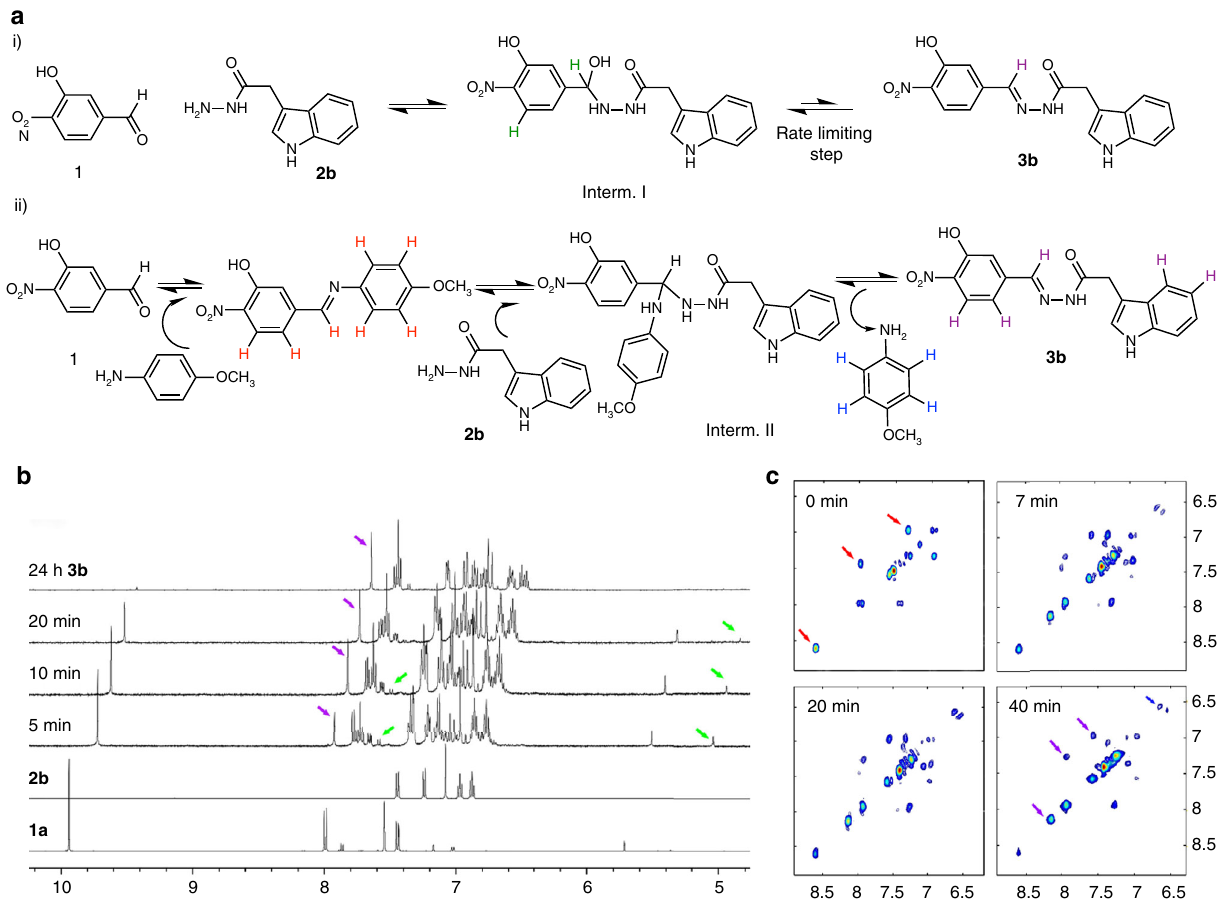
Fig. 3 Acylhydrazone exchange reaction mechanism. a Formation of acylhydrazone 3b in the absence (i) and presence (ii) of p -anisidine. b Real-time 1D 1 H NMR series recorded as a function of time (only a small subset of the resulting spectra hereby shown) of the reaction of 1 (50 mM) and 2b (50 mM) in Tris buffer D 2 O/DMSO- d 6 (1:4) at 298 K (500 MHz). Colored arrows show the positions of speci fi c signals from products and intermediates. The horizontal offset in ppm is 0.1. Note that there is a small fraction of the hydrated aldehyde in the spectra. c Plots of four selected UF-2D-TOCSY NMR spectra taken from the 500 experiments acquired ( 1 : 2b : p -anisidine at 1:1:0.5 in Tris buffer D 2 O/DMSO- d 6 (1:4) at 298 K (500 MHz). Cross-peaks from the Schiff-base intermediate and the fi nal step of formation of 3b are depicted in red and purple